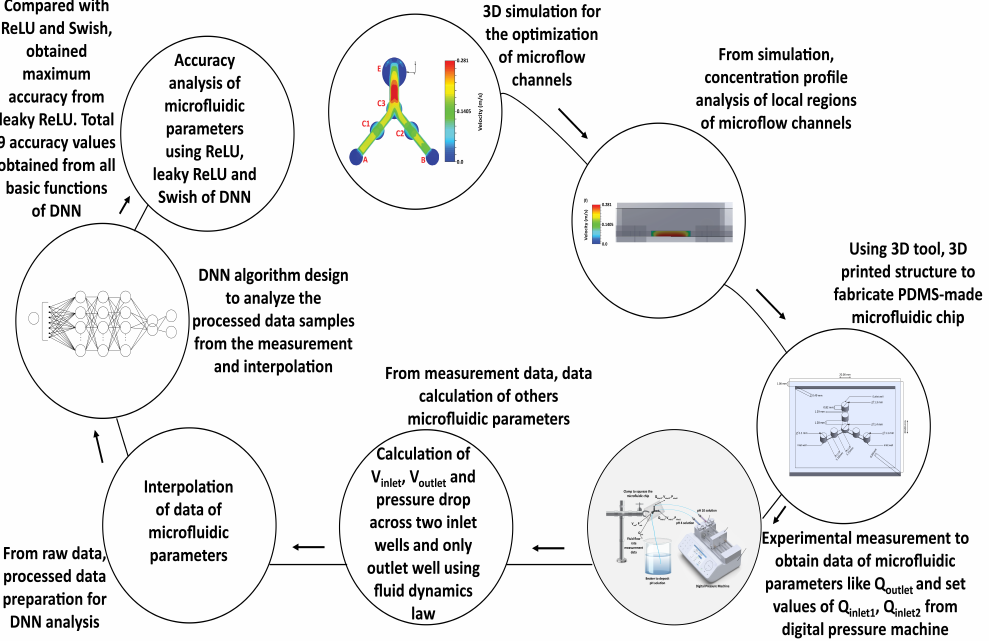
Figure 8. Flow diagram of simulation, optimization, 3D-printing, experimental measurement, calcu- lation of data of microfluidic parameters and DNN algorithm design to analyze the average accuracy of such data of microfluidic